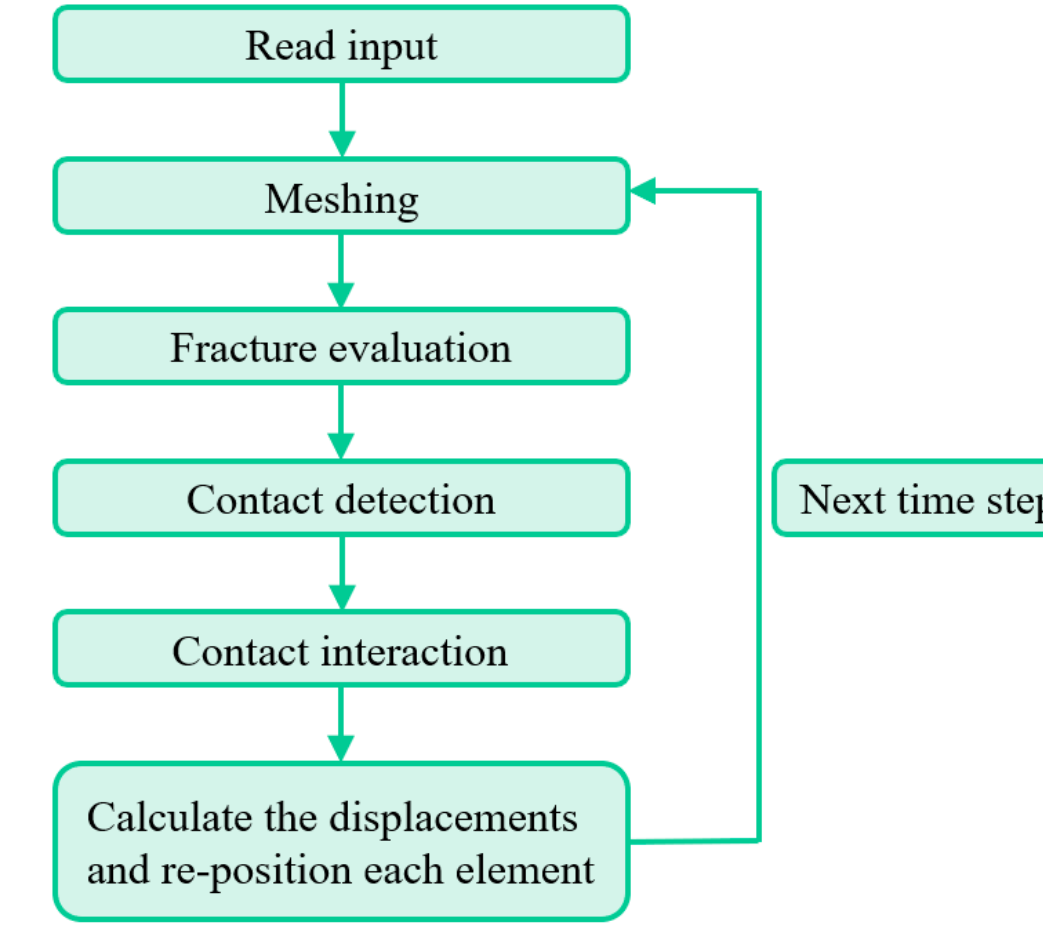
Figure 1. Flowchart of the FDEM.